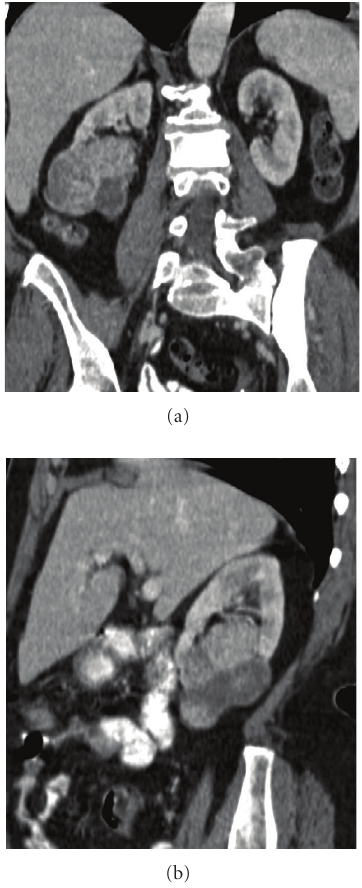
Figure 10: Renal cell carcinoma. (a) Three-dimensional CT with coronal reconstruction, (b) sagittal oblique